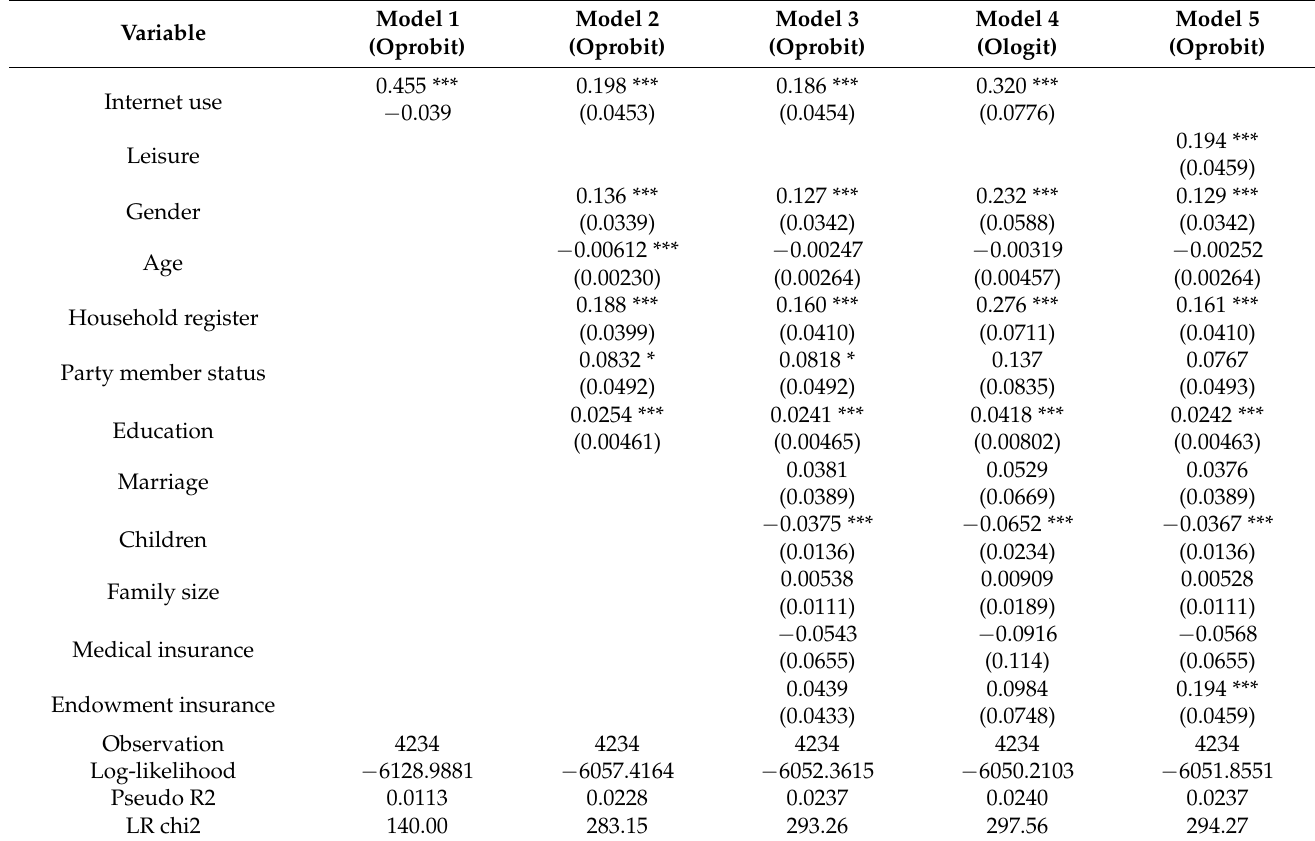
Table 2. Baseline regression